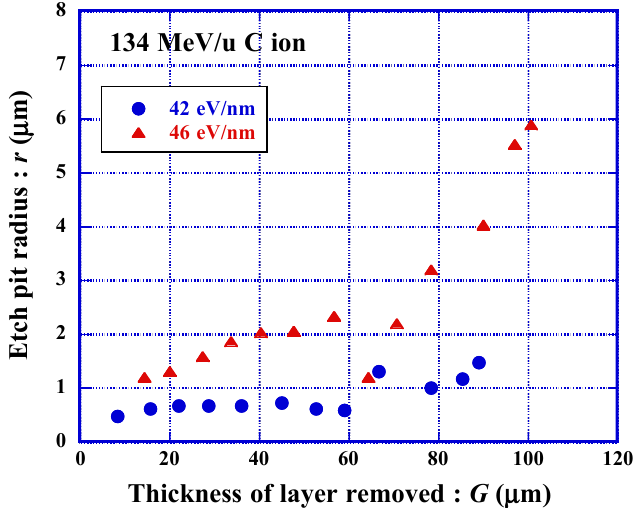
Figure 8. Changes in observed etch pit radius of C ions with indicating stopping powers against the thickness of layer removed.